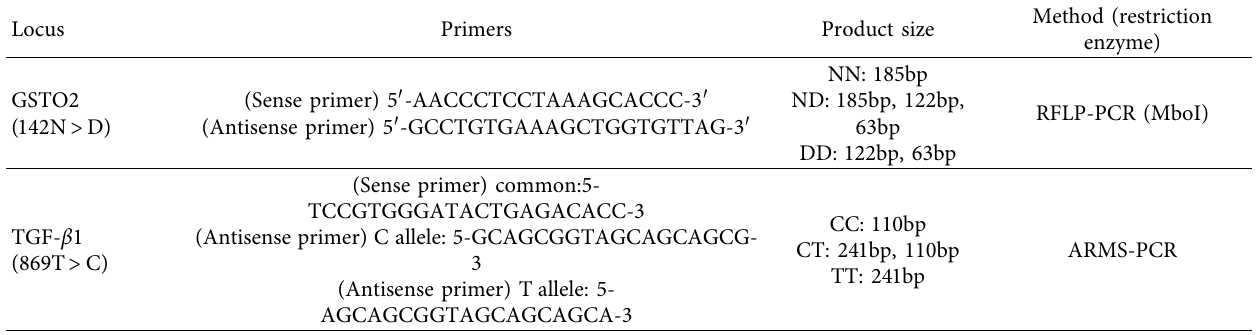
Table 1: The primer, PCR methods, restriction enzymes, and product size for TGF- β 1 and GST-O2.